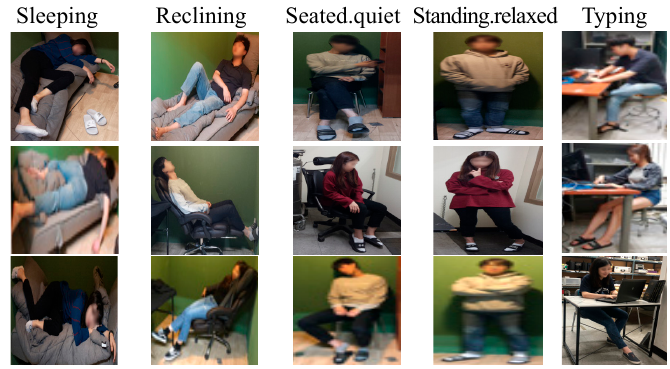
Figure 3. Image samples from the collected dataset.